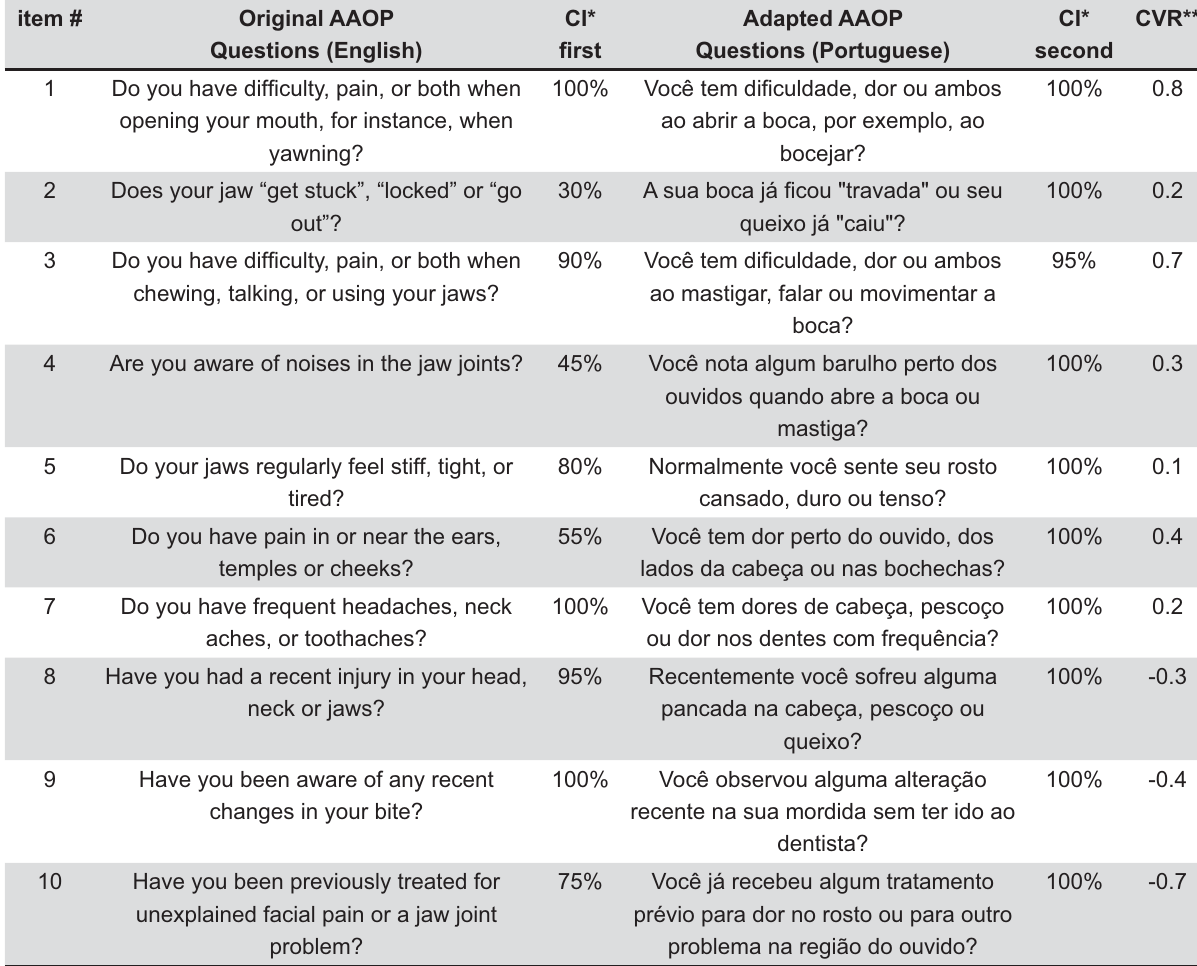
Table 1- Face and content validity results for the American Academy of Orofacial Pain (AAOP) questions (n=20 adolescents and n=20